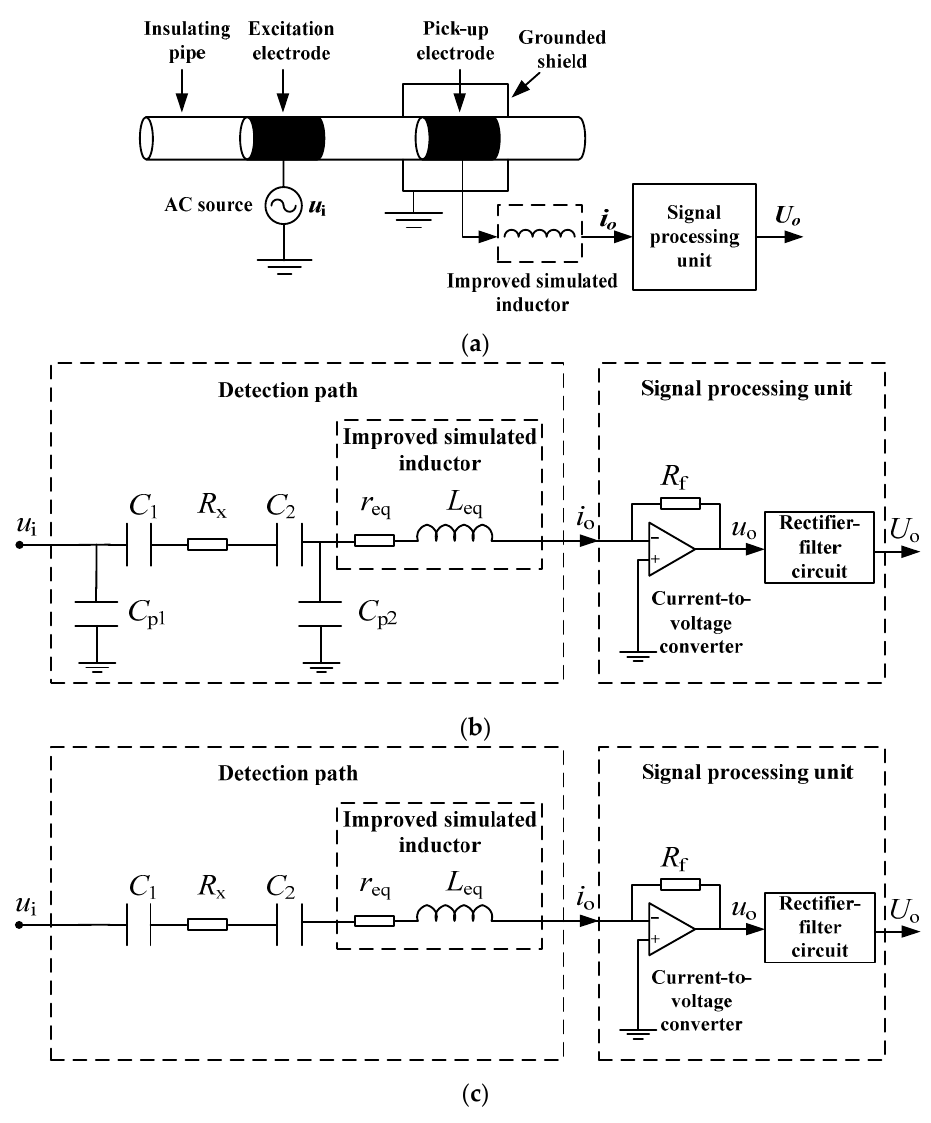
Figure 4. Measurement principle of the new C 4 D sensor: ( a ) Construction; ( b ) Equivalent circuit; ( c ) Simplified equivalent circuit.